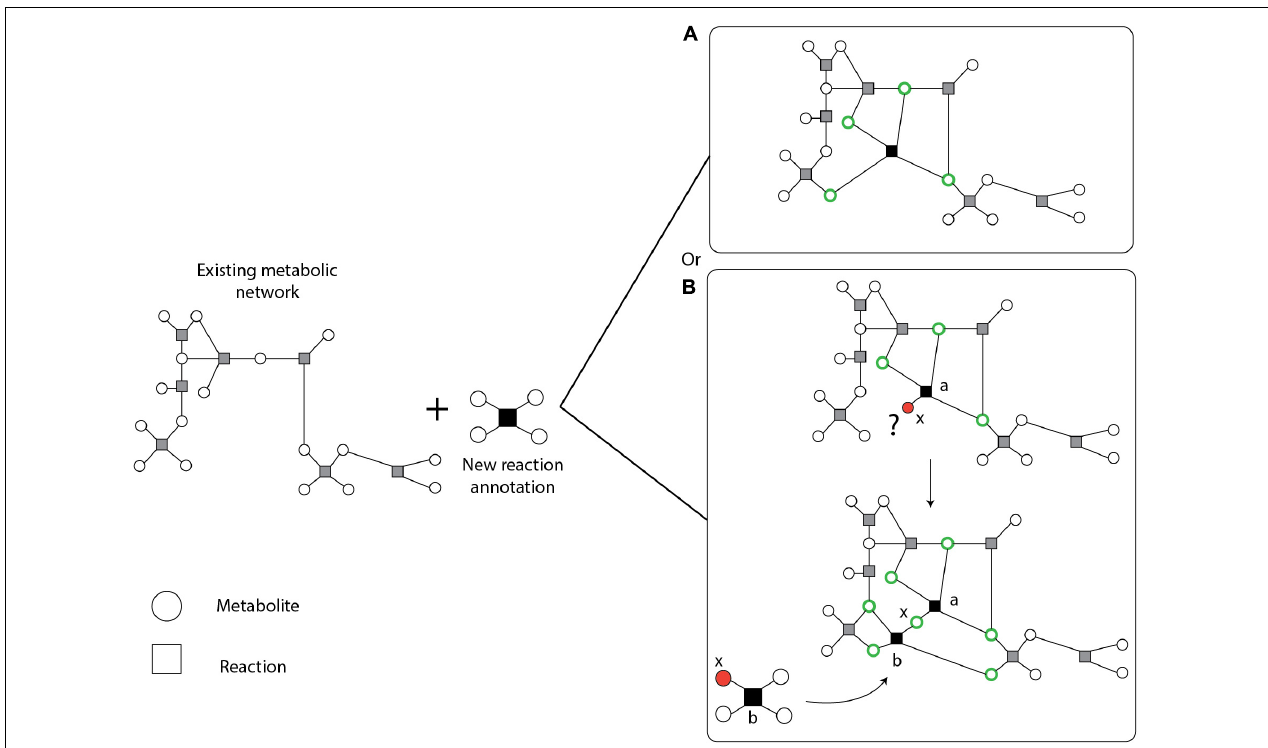
FIGURE 2 | Schematic description of the ReFill algorithm. New reaction annotations are added only if all the metabolites are connected to the existing network. A connected metabolite is denoted in a green circle. An orphan (unconnected metabolite) is denoted in a red circle. (A) A simple case in which all the metabolites comply with the selection rule. (B) In case one or more metabolites are not connected to the existing network, other new reactions may be added to complete the missing connections. For example, consider reaction a to be composed of two substrates and two products, one of which, x (a metabolite that did not exist in the initial network), is not connected to the existing network and is currently an orphan. After the expansion step, the algorithm identified one reaction, b , in which x is used as a substrate. All other metabolites in b exist in the network thus creating a path from reaction a through reaction b to the